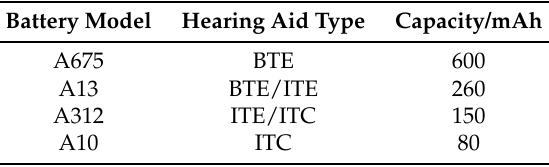
Table 1. Hearing aid battery capacities on the market.